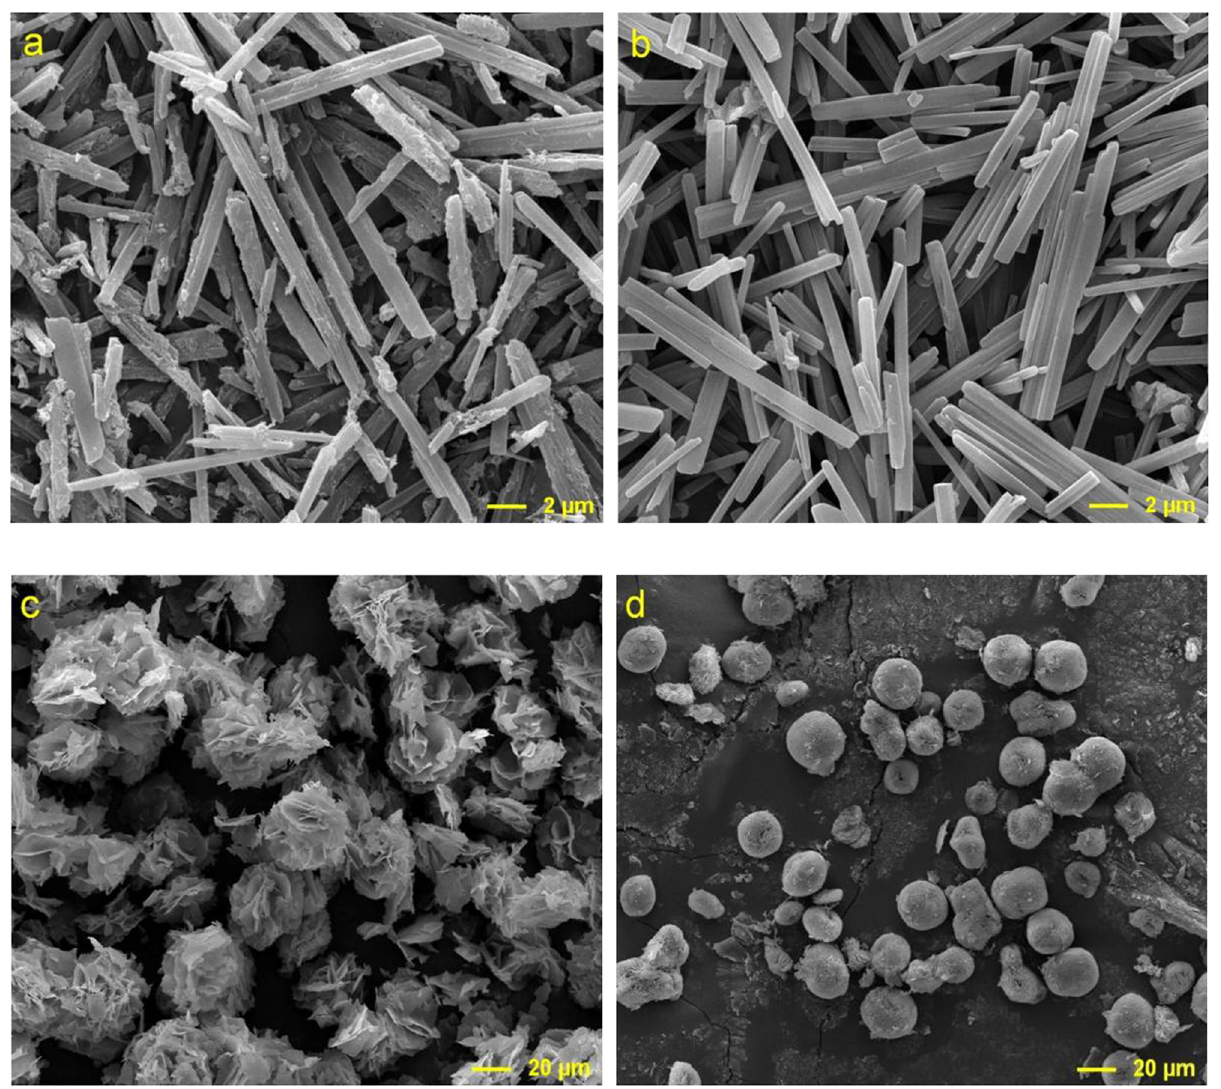
Figure 3: SEM images for the carbonation products with di ff erent aging temperatures: ( a ) 60°C, ( b ) 70°C, ( c ) 80°C, and ( d )